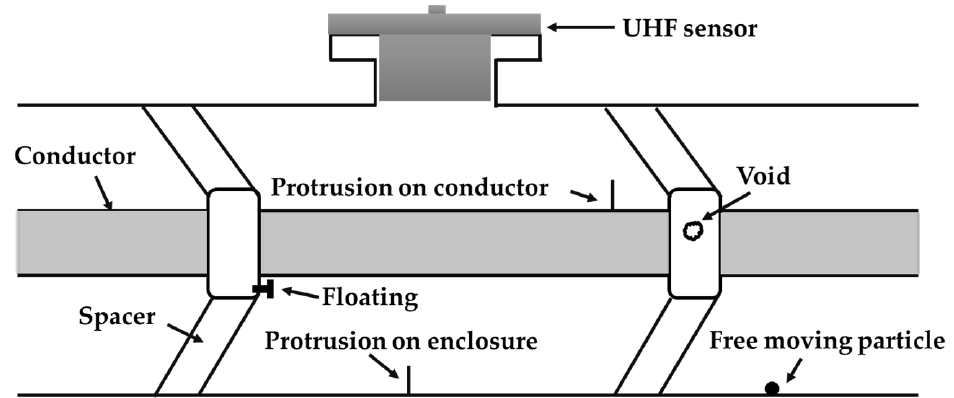
Figure 1. Typical types of PD defects that occur in GIS.